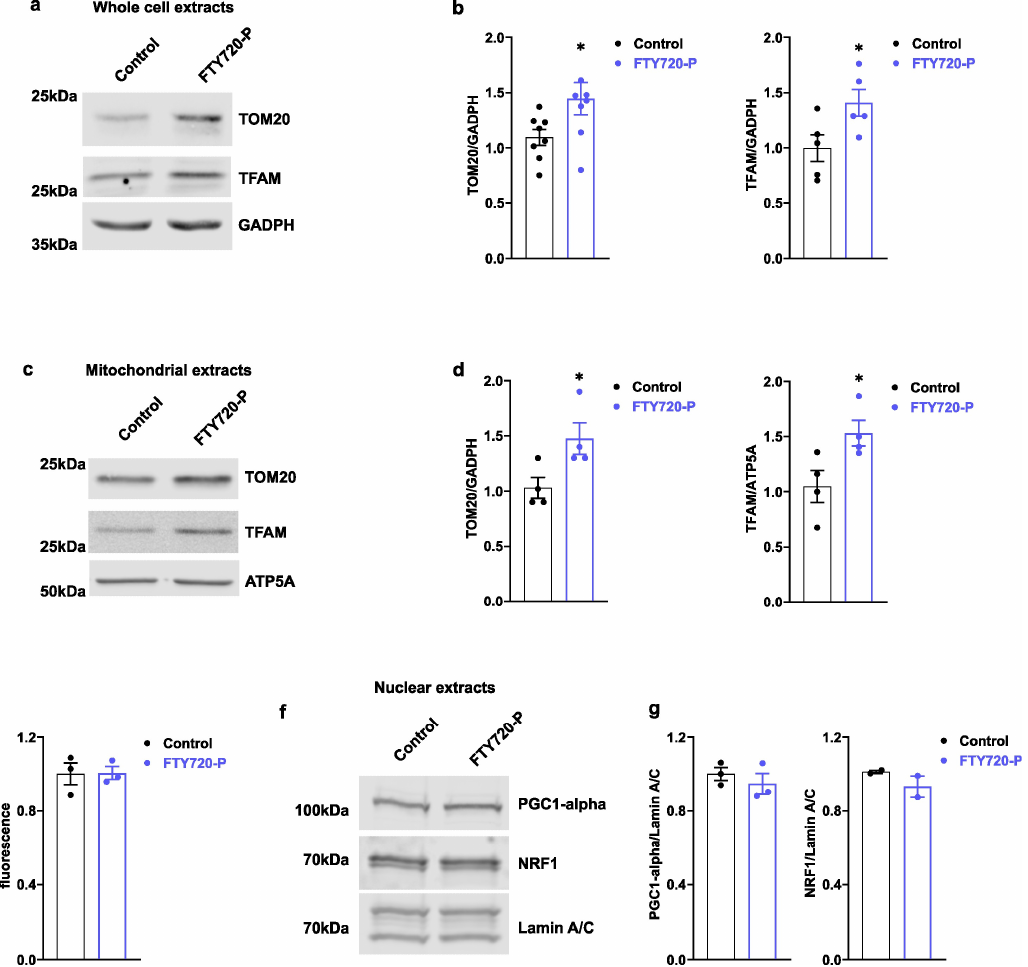
Figure 3. FTY720-P increases TFAM and TOM20 protein expression. AC16 cells were treated with 100 nM FTY720-P for 48 h. ( a , b ) Immunodetection of TFAM and TOM20 in total protein extracts of AC16 cells treated with FTY720-P for 48 h. GADPH was used as a loading control. Data were subjected to unpaired t -test. Data are mean ± SEM. * p -value < 0.05 vs. control cells. Graphs represent 5–7 independent experiments. ( c , d ) Immunodetection of TFAM and TOM20 in mitochondria protein extracts of AC16 cells treated with FTY720-P for 48 h. ATP5A (complex V subunit) was used as a loading control. TOM20 and TFAM densitometric quantifications are shown in panel ( d ). Data were subjected to unpaired t -test. Data are mean ± SEM. * p -value < 0.05 vs. control cells. Graphs represent 3–4 independent experiments. ( e ) Mitochondrial membrane was stained with 100 nM Mitotracker Deep Red for 20 min and analyzed by flow cytometry. Data are mean ± SEM. Graphs represent 3 independent experiments performed in triplicate. ( f , g ) Immunodetection of PGC1-alpha and NRF1 in nuclear extracts of AC16 cells treated with FTY720-P for 48 h. ( g ) PGC1-alpha and NRF1 densitometric quantification. Data are mean ± SEM. Graphs represent 2–3 independent